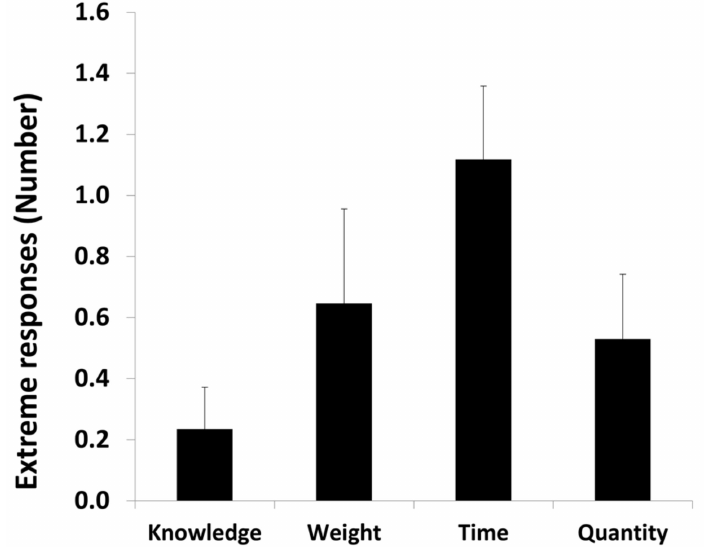
Figure 3. Number of extreme responses as a function of